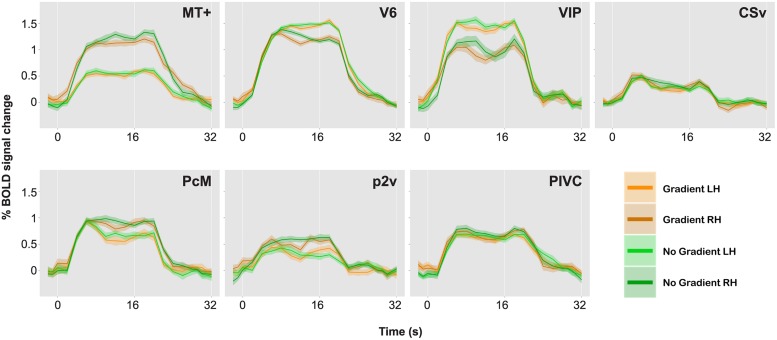
BOLD responses to optic-flow stimuli with and without speed gradient, for MT+, V6, ventral intra-parietal area (VIP), cingulate sulcus visual area (CSv), precuneus motion area (PcM), p2v, and parieto insular vestibular cortex (PIVC) in one representative brain. Time series data for the two conditions and for the two hemispheres are overlaid. A single time series was computed from 10 runs. The time series was then collapsed over a single stimulus cycle of 32 s: The stimulus-presentation block lasted from 0 to 16 s followed by a 16-s ISI. Error bars indicate SE.